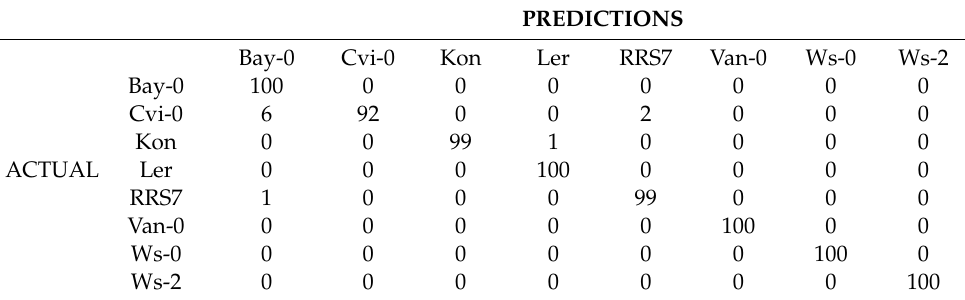
Table A3. Confusion matrix for roots using only the most identifiable ecotypes. The diagonal elements are the correct estimation of the random forest classifier.